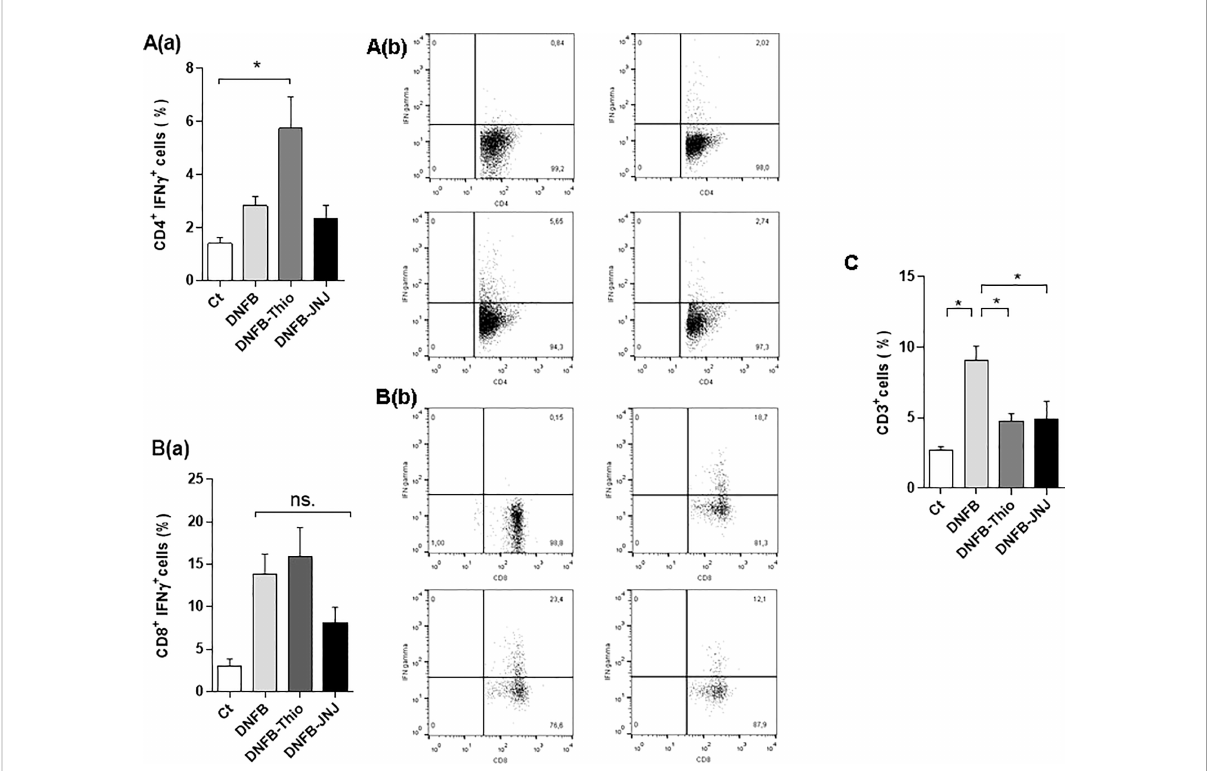
FIGURE 4 Analysis of the induction of a Th1/Tc1 pro fi le. The bars represent mean ± SEM IFN- g production by CD4 + ( A , panel a) and CD8 + ( B , panel a) cells in the gate of CD4 and CD8 lymphocytes, respectively. The intracytoplasmic determination was made from leukocytes from draining lymph nodes of treated mice after being cultured for 24 hours with PMA (10 ng/ml) + ionomycin (1 ng/ml), with the addition of 10 µg/ml brefeldin A (Golgi plug). Permeabilized cells were stained with PE-labeled IFN- g . * p < 0.05. ANOVA with Tukey ’ s post-test ( n = 8). A representative dot plot of CD4 + IFN- g + ( A , panel b) and CD8 + IFN- g + ( B , panel b) cells is shown. (C) The percentage of T lymphocytes (CD3 + ) at the administration site. Bars represent the mean ± SEM. ns (not signi fi cant); * p < 0.05. ANOVA with Tukey ’ s post-test ( n =